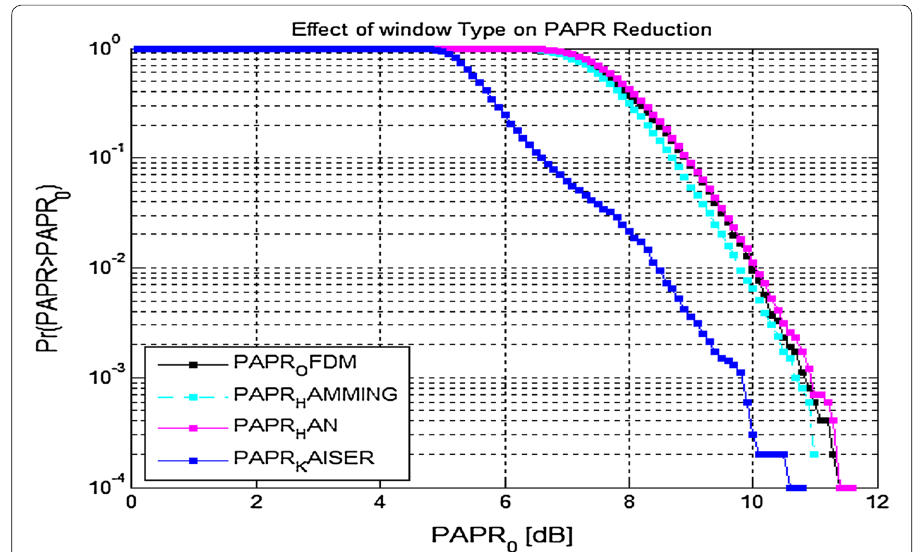
Fig. 5 CCDF performance for PAPR reduction for Hamming, Hanning and Kaiser windows